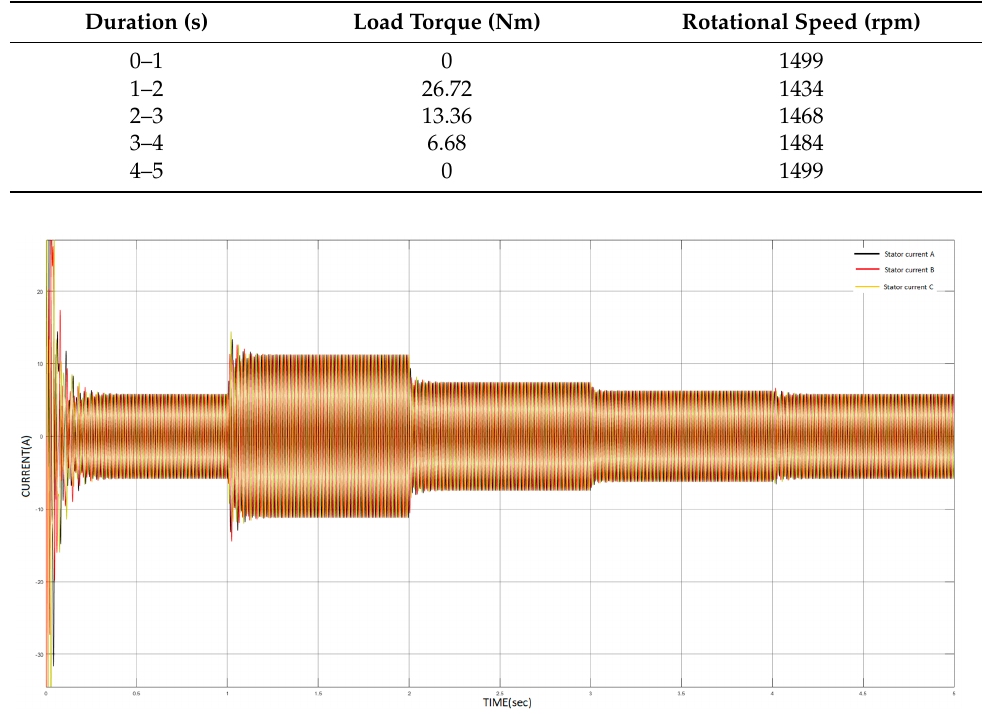
Signals 2023 , 4, FOR PEER REVIEW Figure 2. Time series of 3–phase stator currents during healthy operation. Figure 2. Time series of 3–phase stator currents during healthy operation.